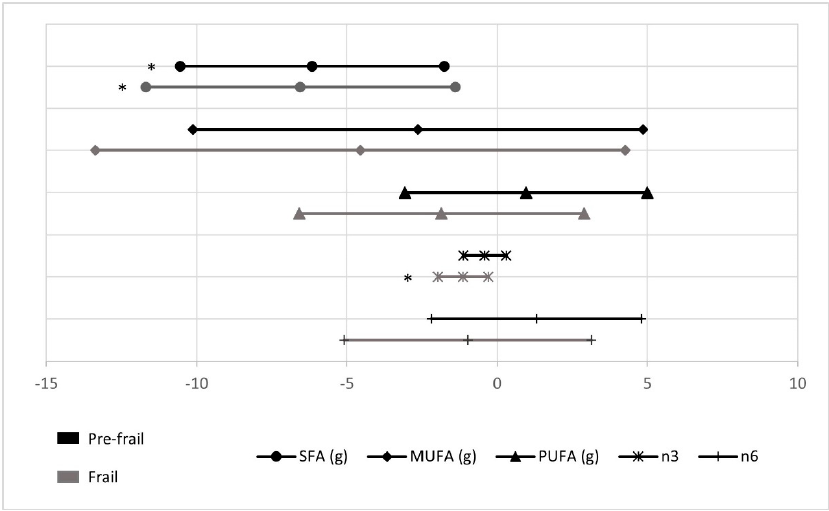
Figure 2. Fat type intake in pre-frail and frail groups compared with robust (reference group). * Statistically significant differences ( p value < 0.05). A lower consumption of SFA was observed in frail and pre-frail ( β = − 6.6 ± 2.6 and β = − 6.2 ± 2.2, respectively) when considering robust as reference, and only frail presented a